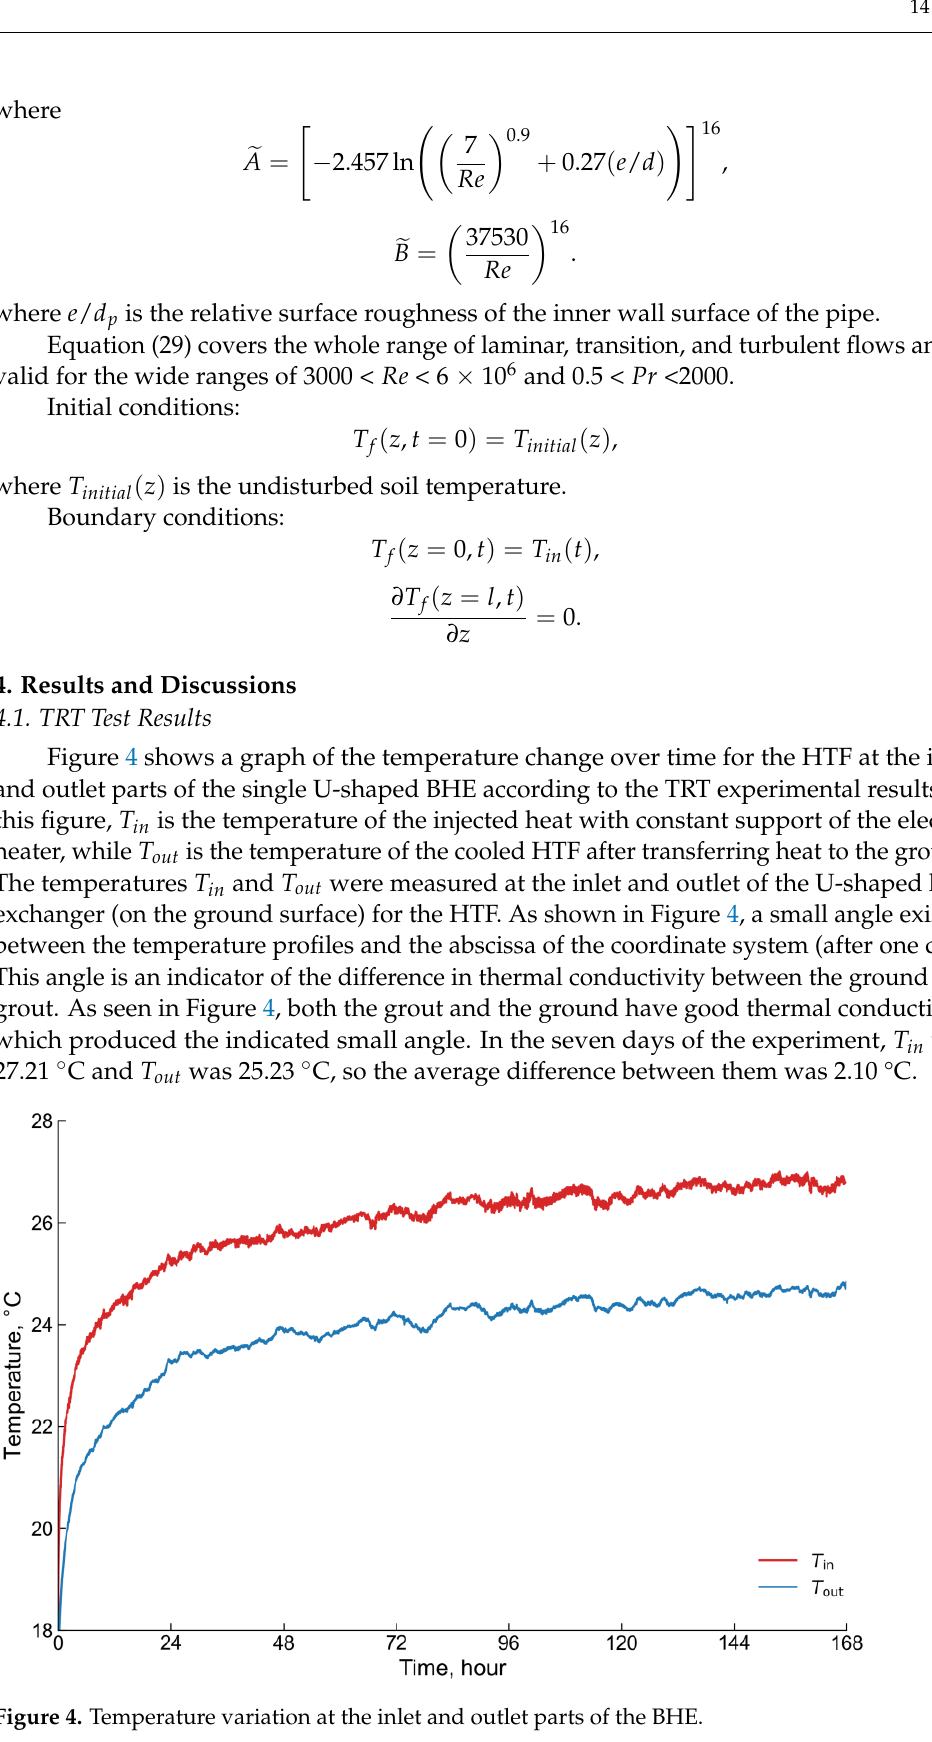
Figure 5. Undisturbed initial temperature of the ground with depth. Figure 6 is a plot of the undisturbed reference soil temperature versus time, which was obtained using an alternative method. This alternative method consisted of determin- ing the temperature of the soil before heat injection, which was carried out with the tem- perature values 𝑇 𝑖𝑛 and 𝑇 𝑜𝑢𝑡 . This was achieved by long-term circulation of the HTF until a thermal balance was reached between the fluid in the heat exchanger pipes and the soil. It appeared that after 11 h the average temperatures of 𝑇 𝑖𝑛 and 𝑇 𝑜𝑢𝑡 were 14.5 °C. During the operation of the circulation pump, heat is released, the influence of which was insig- nificant for the experiment, therefore this heat was not considered when determining the undisturbed soil temperature. The difference between the average temperatures of the undisturbed soil obtained by the first and second methods was only 0.5 ℃ . Since direct measurement is considered more accurate, 15.0 °C was used as the average undisturbed soil temperature for the line-source model when determining the BHE thermal resistance.